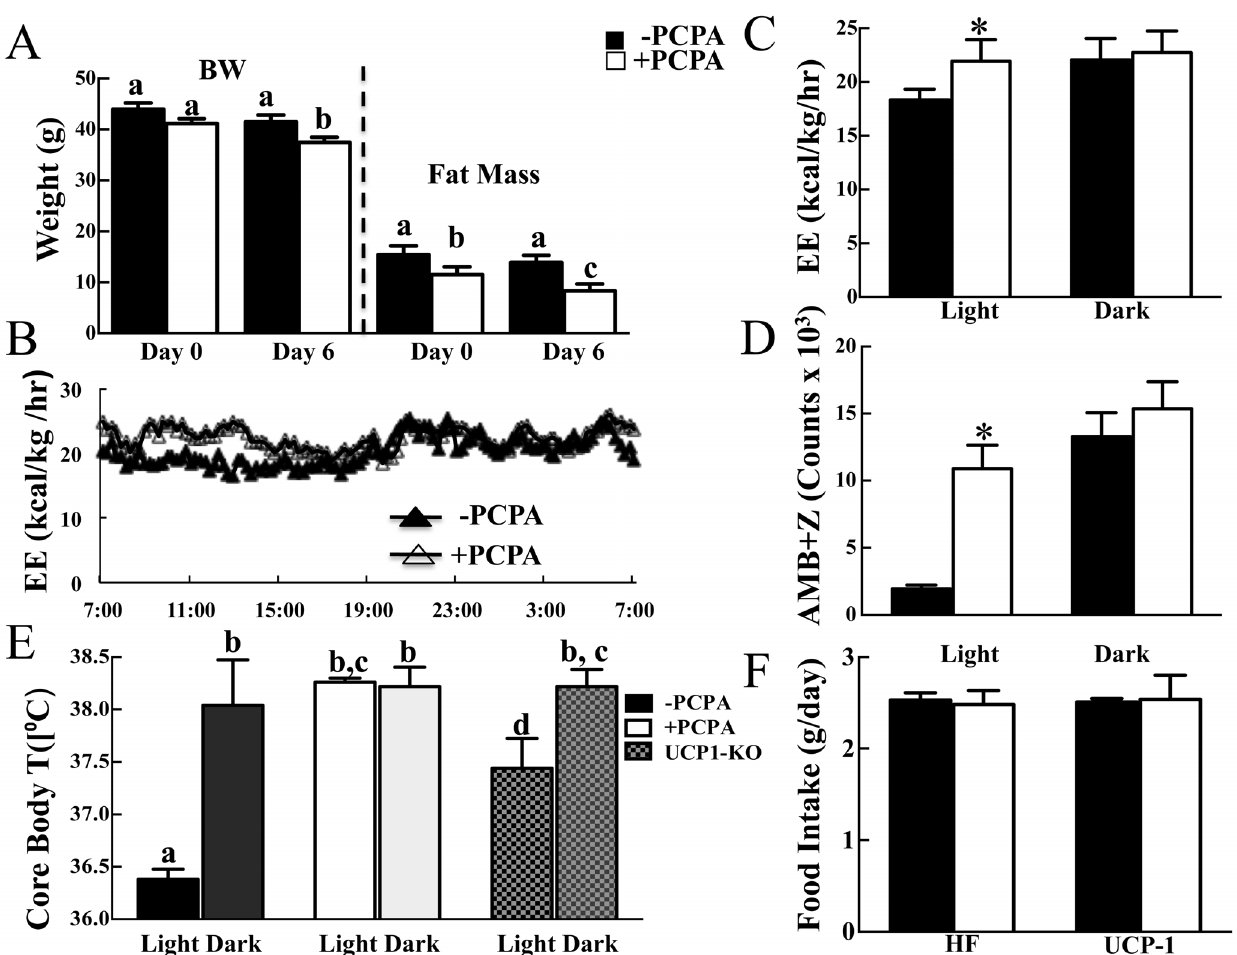
Figure 7. Short-term PCPA treatment increases locomotor activity and energy expenditure in the light cycle. Mice were fed HFD for 7 weeks and injected PCPA intraperitoneally every other day for a total of three times during the last week. (A) Body weights and fat masses of HFD-fed mice were measured immediately prior to PCPA injection and two days after the third injection. Indirect Calorimetry was carried out immediately after the third injection. (B, C) Average energy expenditure during the 12-hour light cycle from 7 am to 7 pm and the 12-hour dark cycle from 7 pm to 7 am. (D) The sum of ambulatory and vertical movements. (E) Core body temperatures of HFD-fed WT or UCP1-KO mice 24 hrs following the second PCPA injection. The measurement was taken in the light cycle unless otherwise noted. (F) Daily HFD intake during the six days of short-term experiment. Bars represent means 6 standard errors of each group (n=5). (*) indicates a statistically significant difference (p , 0.05) between PCPA treated and non-treated groups unless otherwise